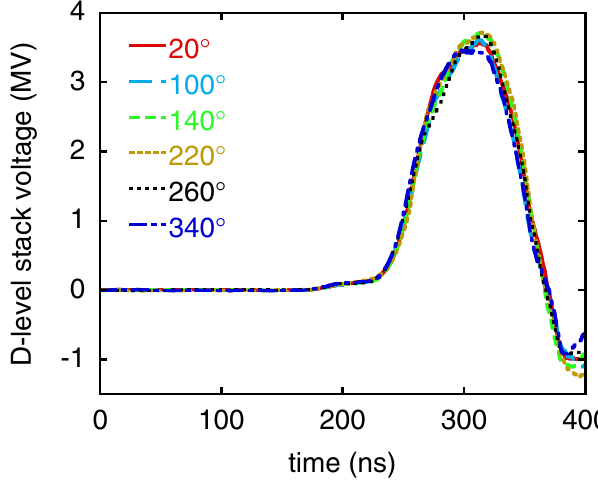
FIG. 12. (Color) Measurements on Z -shot 1548 of the D-level insulator-stack voltage at 6 azimuthal locations.